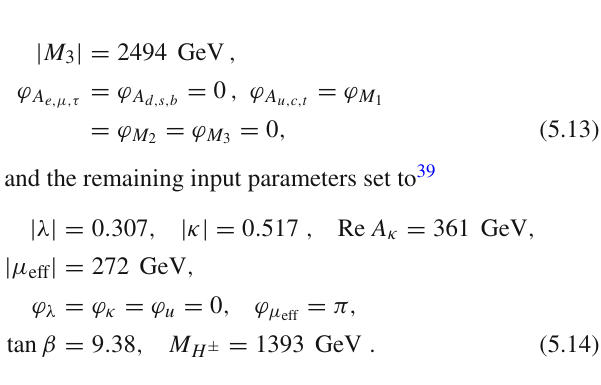
decaying into Z A 1 and Z A 2 pairs. In the right plot, however, red: s